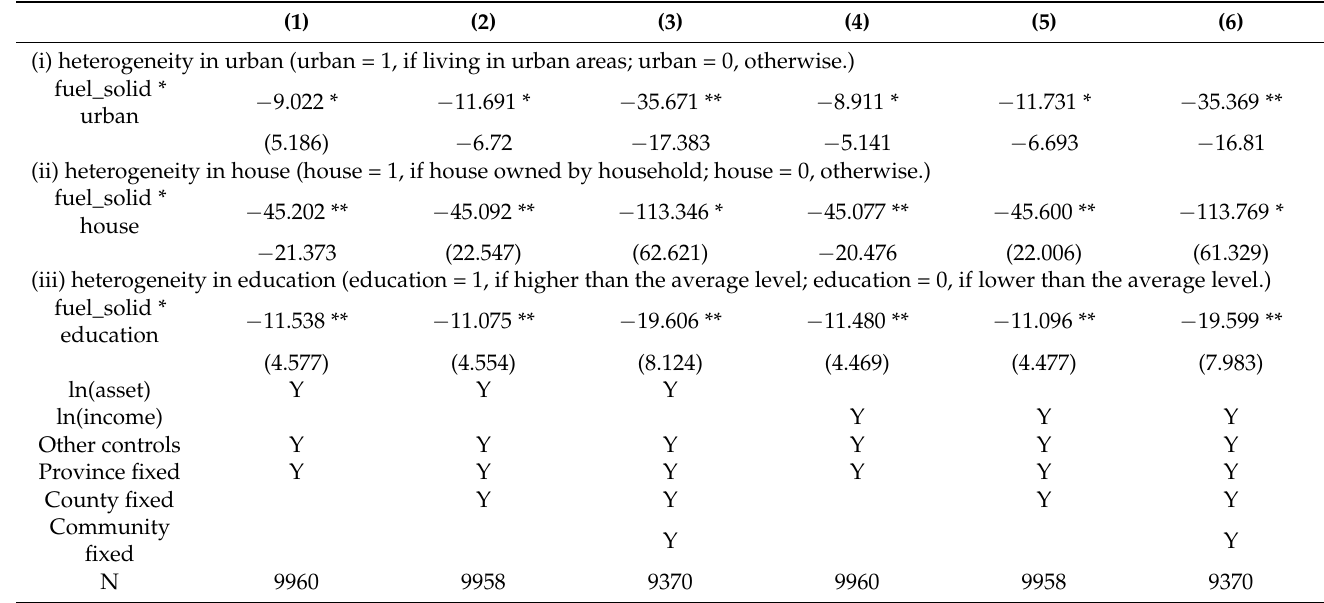
Table 7. Heterogeneity analysis of effects of solid cooking fuels on medical